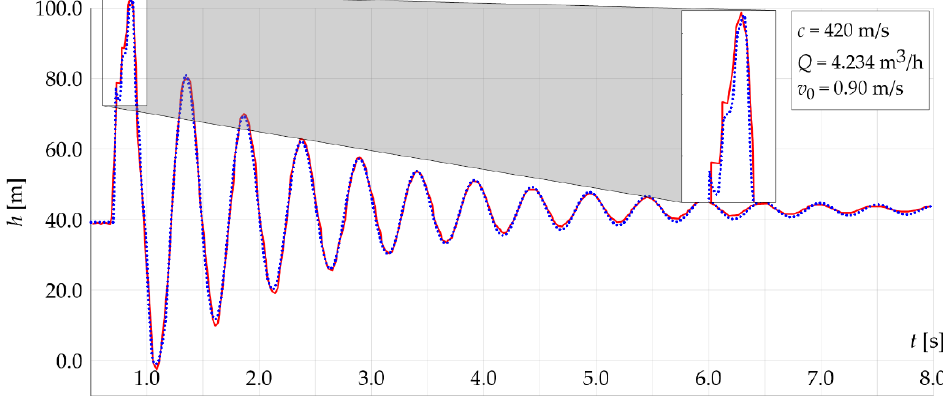
Figure 7. Calculated and observed pressure oscillations during experiment no. 4.